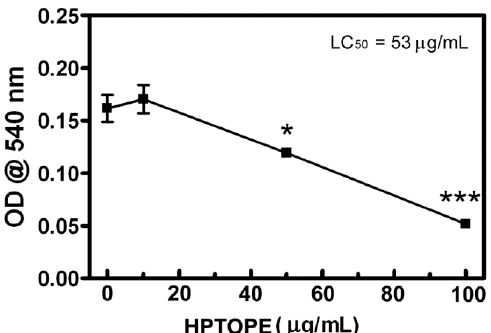
Figure 1. Cell viability of cortical neurons exposed to increasing concentrations of high-pressure and temperature extract from olive pomace (HPTOPE). After 14 days in vitro (DIV), neurons were incubated for 24 h with the indicated HPTOPE concentrations. Cell viability was evaluated by neutral red uptake (NRU) assay. Values represent means ± SEM from three independent experiments in triplicate. * p < 0.05 and *** p < 0.001 vs. control, according to ANOVA, followed by Tukey’s post-hoc